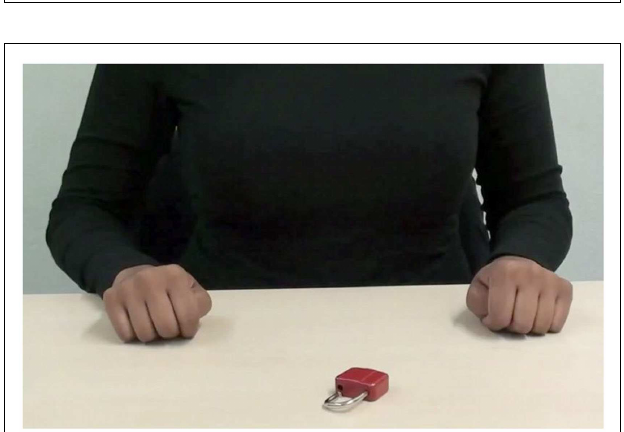
FIGURE 1 | Screenshot of action video Unlock the lock! presented in the in-group condition.